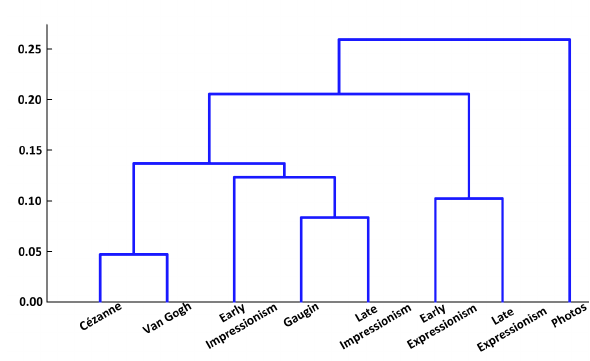
Figure 9. Hierarchical clustering of styles. The length of the lines denotes the stylistic distance.